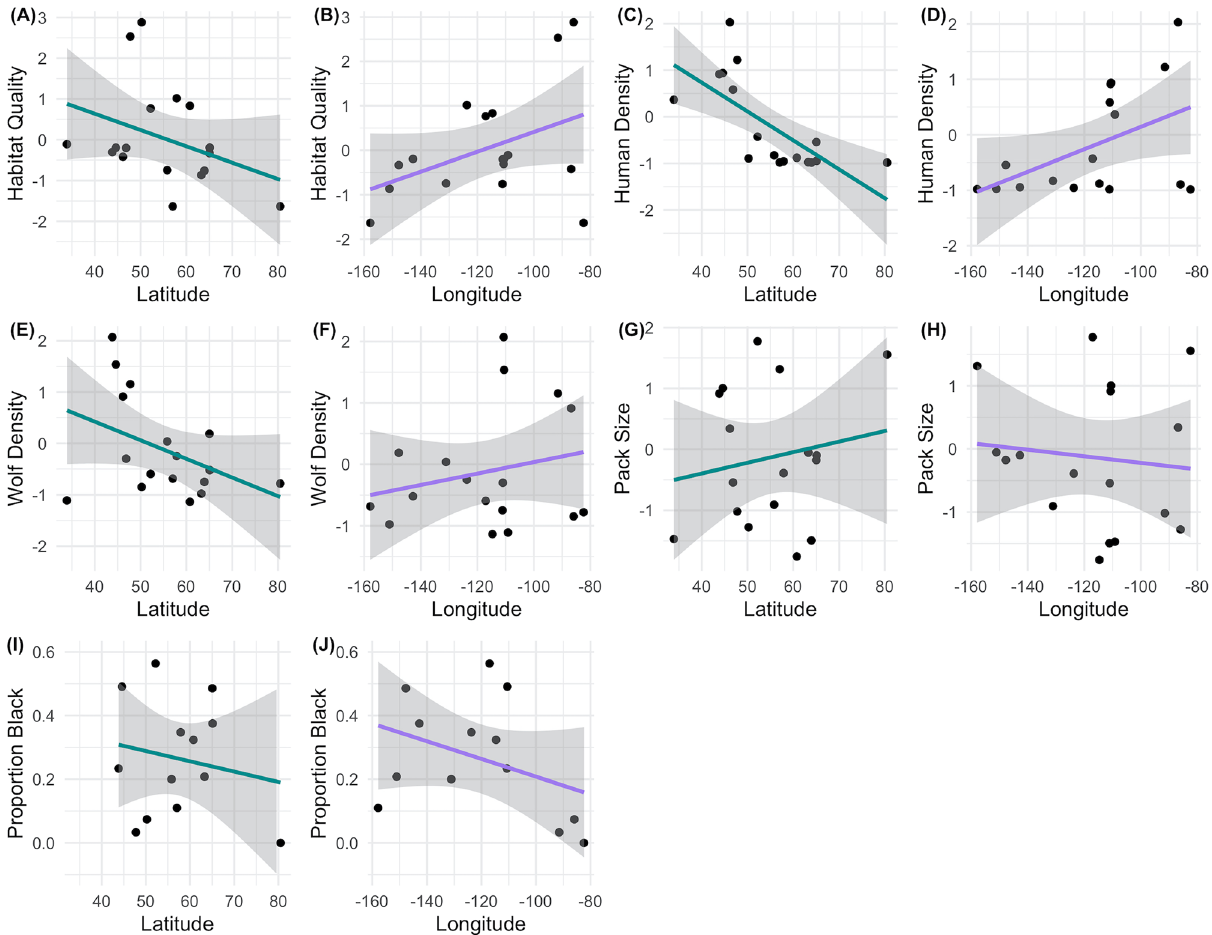
Figure 2. The effect of latitude (teal lines) and longitude (purple lines) on selected standardized, continuous predictor variables that were included in the generalized linear mixed models 39 : ( A , B ) habitat quality, ( C , D ) human density, ( E , F ) wolf density, ( G , H ) pack size, as well as ( I , J ) proportion of black wolves (for I , J , note that MI, MT, and N NWT were removed due to lack of coat color data; MEXICAN was removed as Canis lupus baileyi does not present a black phenotype). Gray polygons are 95% confidence intervals around univariate regression